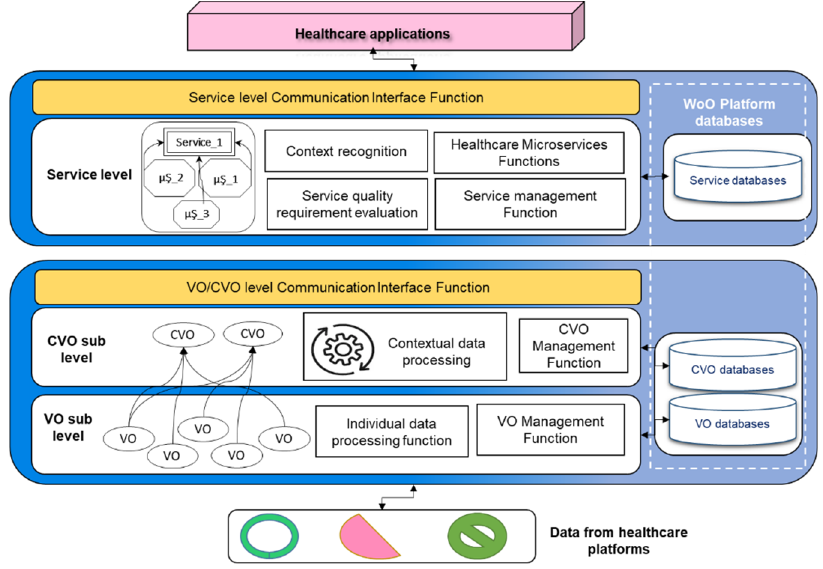
Figure 7. Web objects functional model.